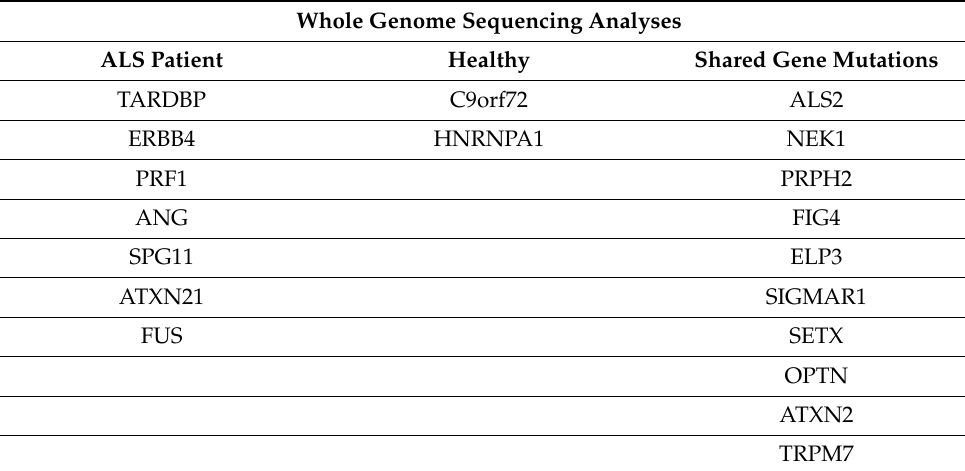
Table 1. List of gene mutations in ALS patient and healthy